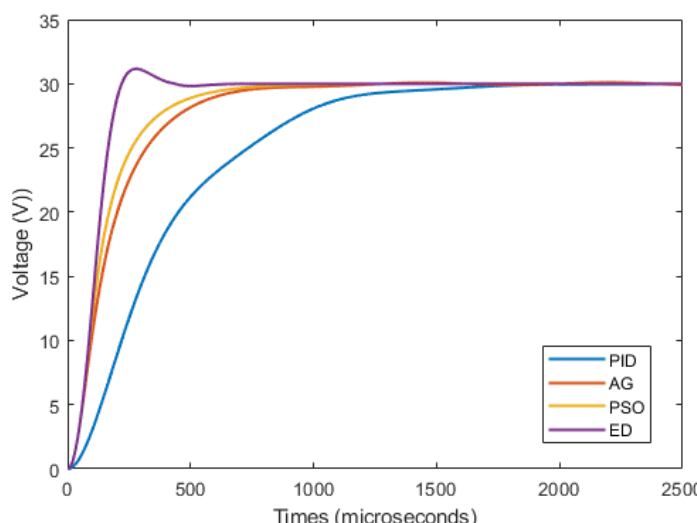
Figure 9. Response of the best GAPID control for each strategy.